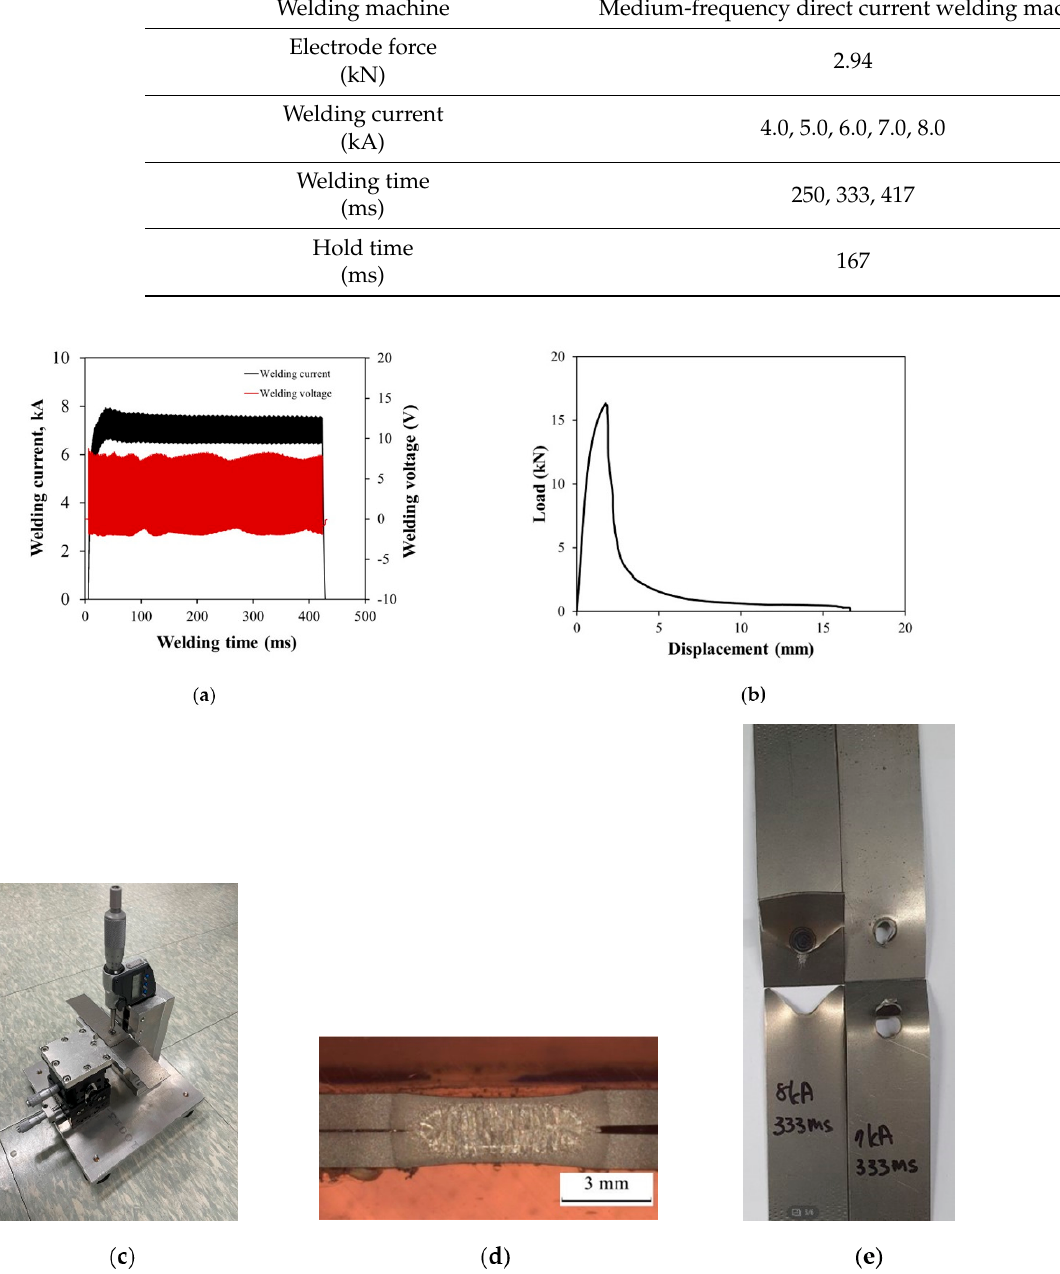
Figure 3. ( a ) Measured current and voltage signals. ( b ) Stress–strain curve obtained from a tensile test. ( c ) Indentation depth measurement. ( d ) Cross-sectional view of a spot-welded joint. ( e ) Test specimen after tensile shear test.